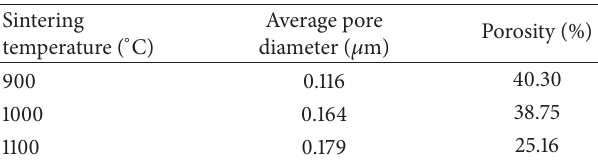
Figure 4: Variation of pore diameter versus mercury intrusion volume of the membranes sintered at 900, 1000, and 1100 ∘ C. Table 1: Values ofthe average porediameter and porosity of sintered ceramic membranes at 900, 1000, and 1100 ∘ C.